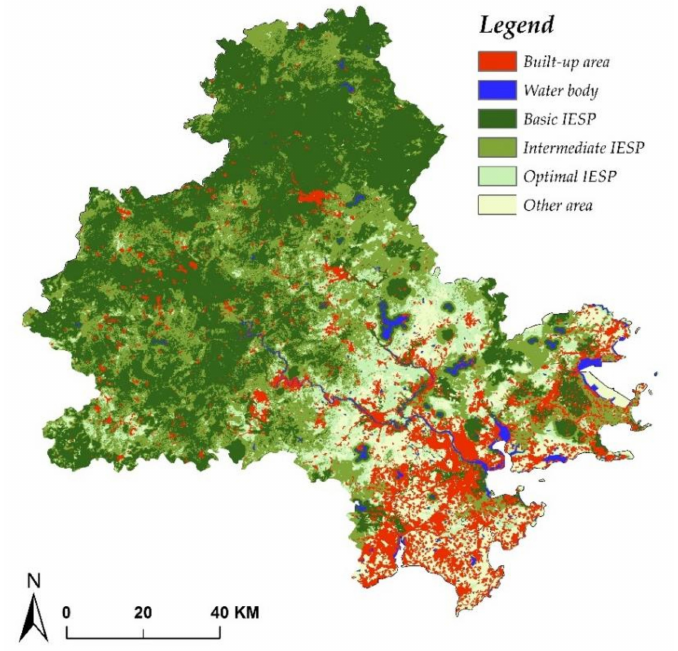
Figure 5. Integrated ESP with three di ff erent scenarios in Quanzhou